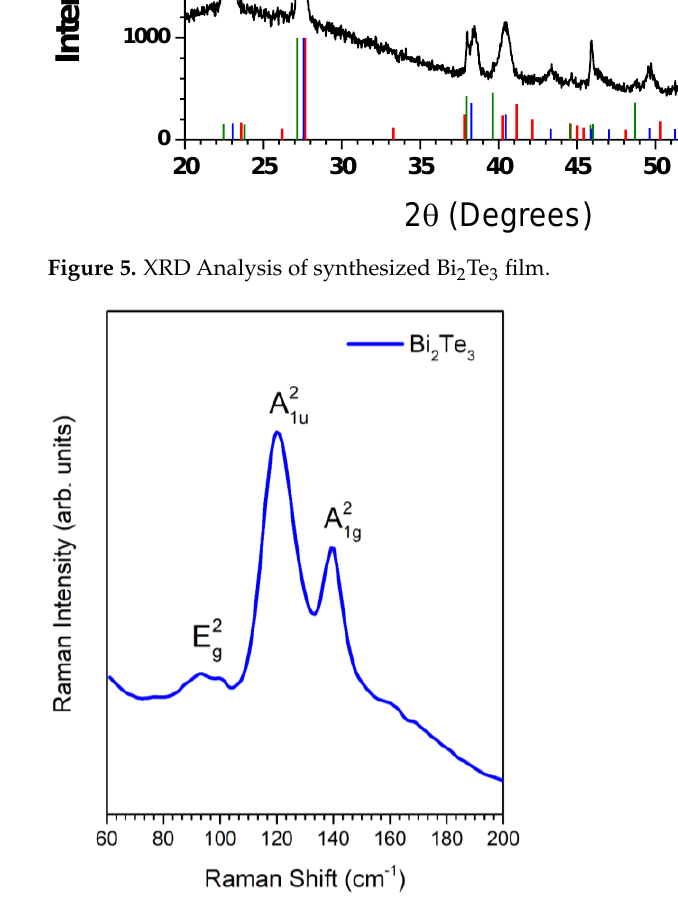
Figure 5. XRD Analysis of synthesized Bi 2 Te 3 film.